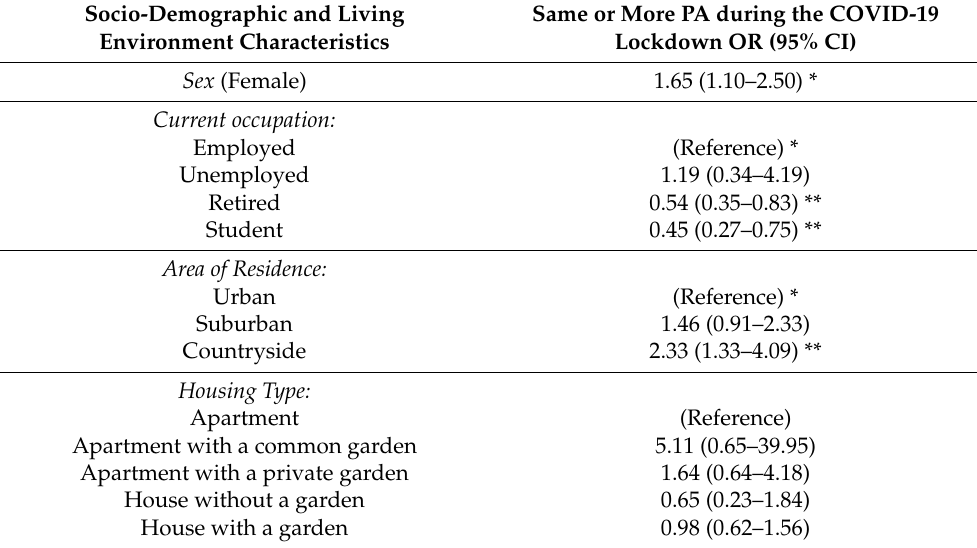
Table 2. The Relationships between Socio-Demographic and Living Environment Characteristics and the Level of Physical Activity during the COVID-19 Lockdown.